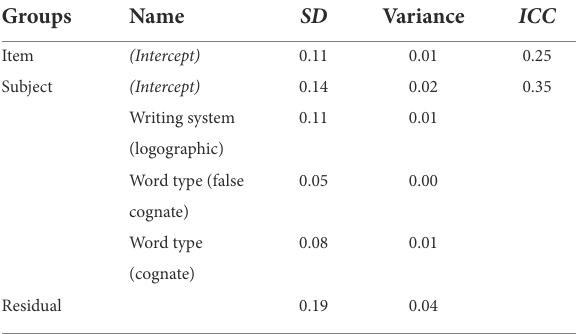
TABLE 6 Random effects from linear mixed model of RTs with item and subject as random effects in the recognition tasks.